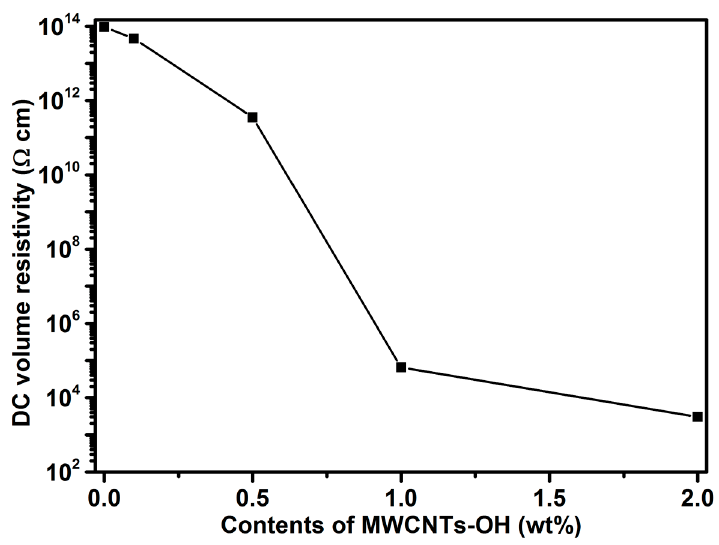
Figure 8. DC volume resistivity of the nanocomposite bioplastics.